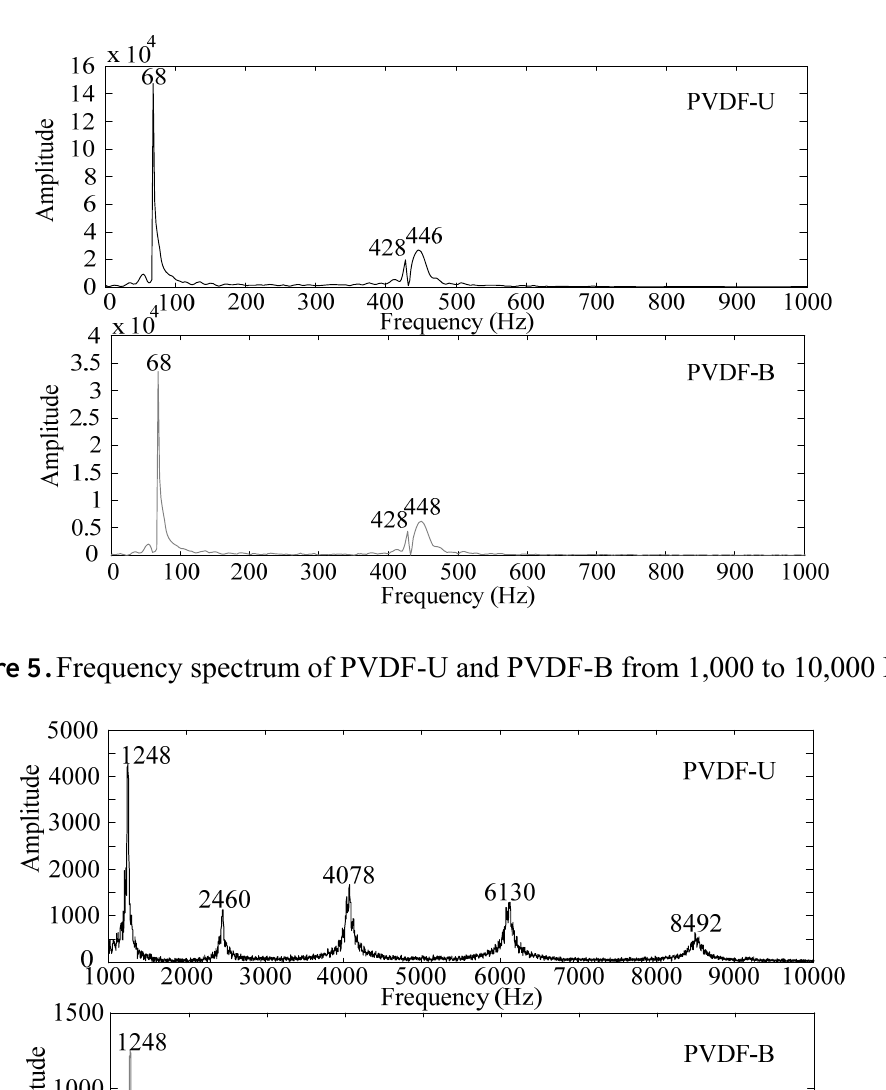
Figure 4. Frequency spectrum of PVDF-U and PVDF-B within 1,000 Hz.